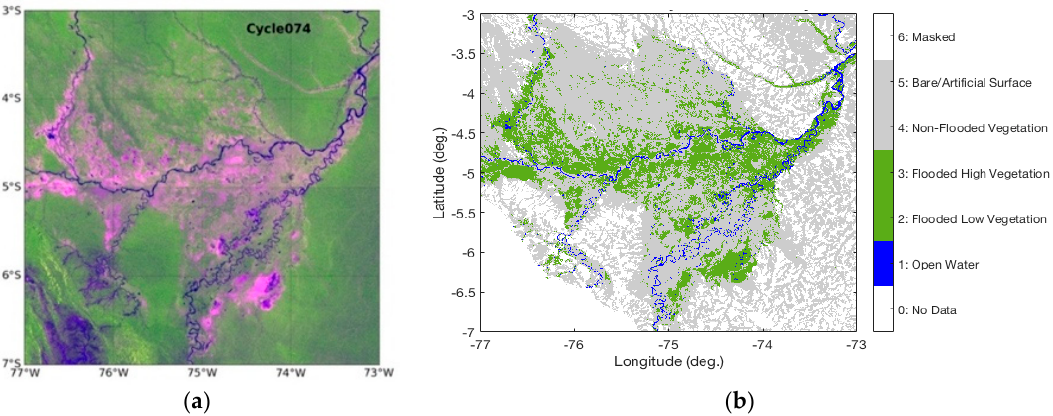
Figure 4. ( a ) False color composite of the PALSAR-2 mosaic for Cycle 74 (May 08 to May 21, end of the high flood season) where R: HH polarization, G: HV polarization, and B: HH/HV polarization ratio, provided by Reference [10], note R = Red, G = Green, B = Blue, H = Horizontal, V = Vertical. ( b ) PALSAR-2 derived inundation classification for cycle 74. The inundation classification was originally derived with seven classes [10]. For this study, those classes were condensed to four (1) Flooded Vegetation, (2) Open Water, (3) Non-Flooded vegetation, and (4) areas that were Masked or for which there was no data.